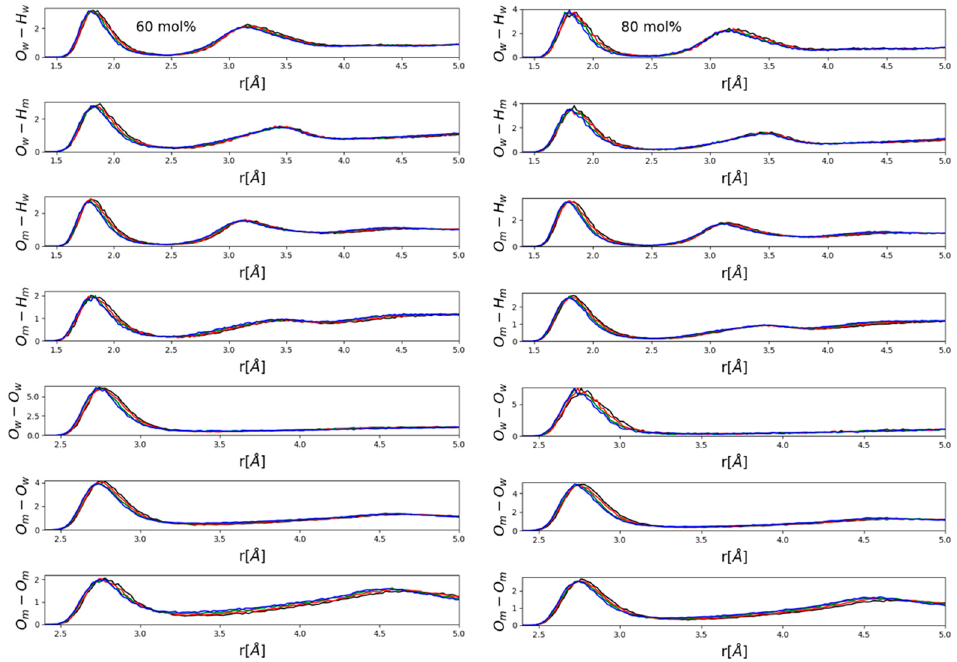
Figure 5. Hydrogen-bonding related partial radial distribution functions in mixtures with high alcohol contents, 60 (left panel) and 80 (right panel) mol% methanol. Black lines: 0.15 GPa; red: 0.4 GPa; green: 0.8 GPa; blue: 1.2 GPa. Indices “m” and “w” refer to “methanol” and “water”, respectively.